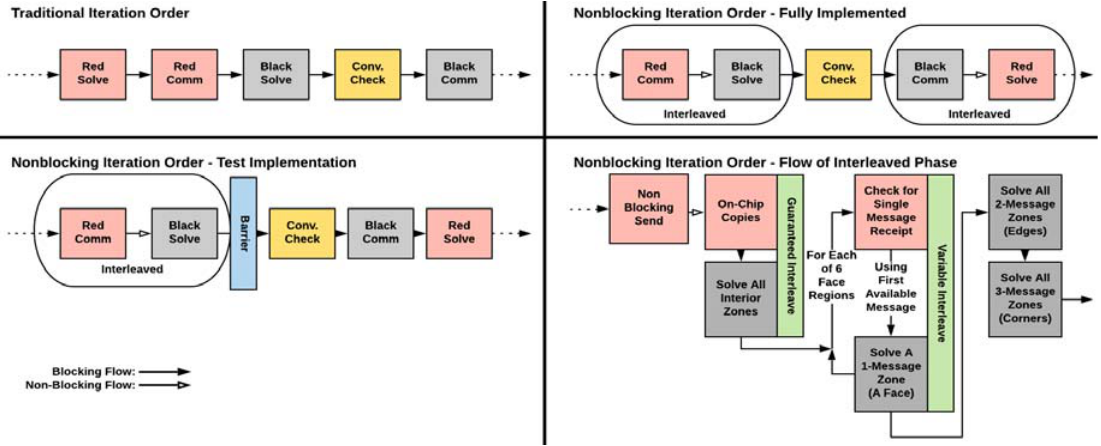
Figure 2: PIDOTS's Iterative Flow for Various